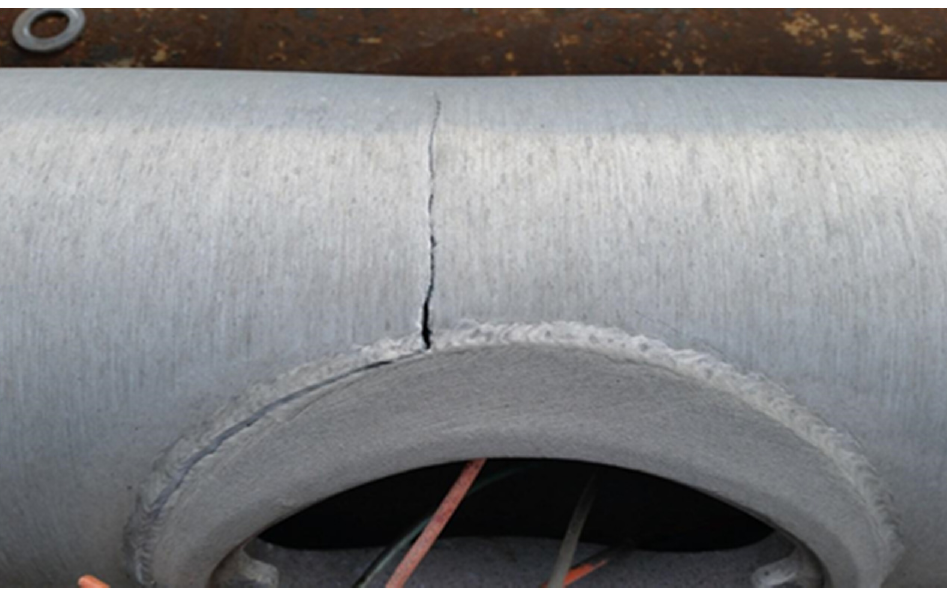
Figure 1. Aluminum light pole containing a fatigue crack within the field